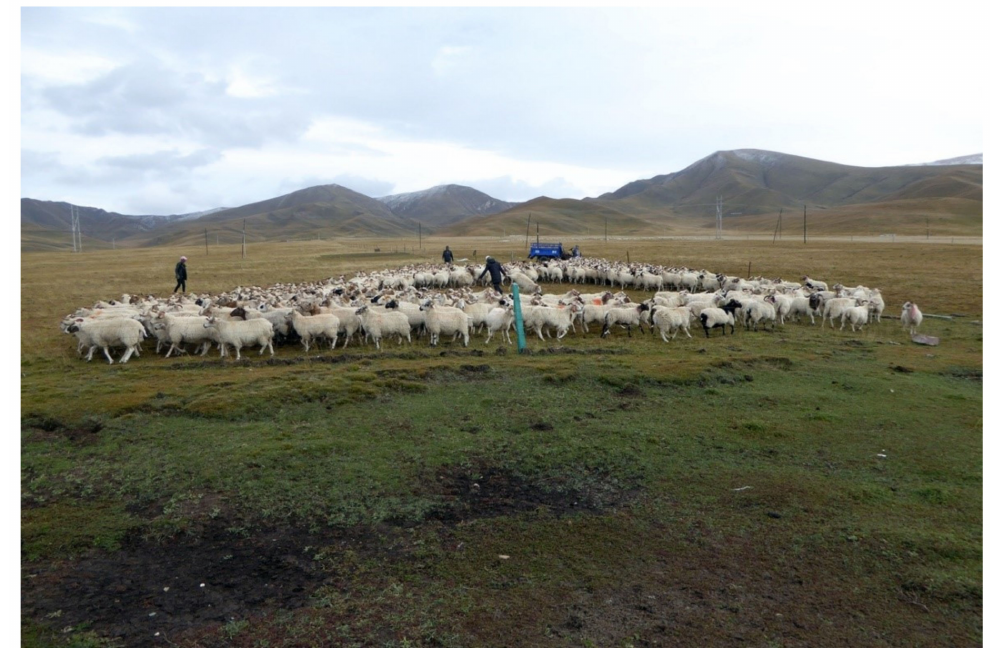
Figure 7. Livestock grazing is practiced along the valley bottom near the proposed Qilianshan Pilot National Park. They graze their livestock on the mountain slopes in the proposed national park area (background) in summer, which resulted in a conflict with the park administration. (Photo: T.W., September 2017).